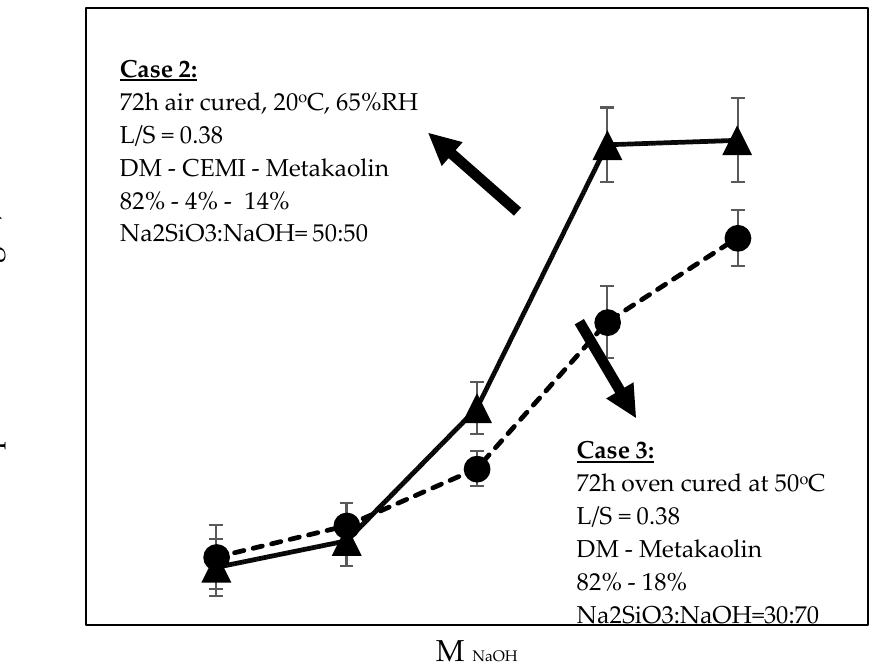
Figure 6. Relationship between 72 h compressive strength and NaOH molarity of formulations in Cases 2 and Case 3 at Na2SiO3:NaOH ratios of 50:50 and 30:70, respectively.